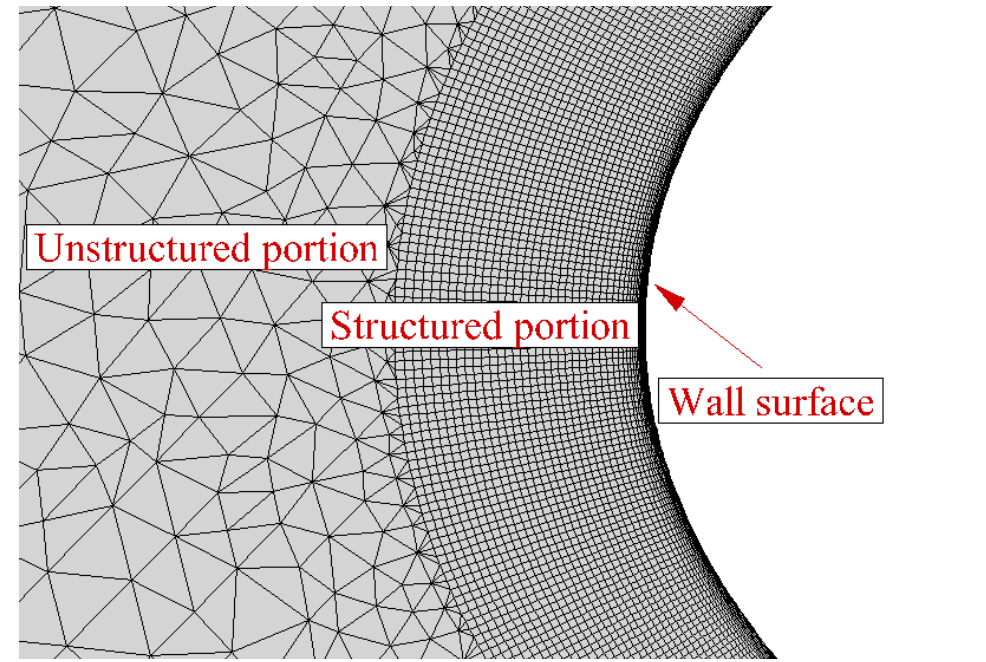
Figure 3. The mesh type of